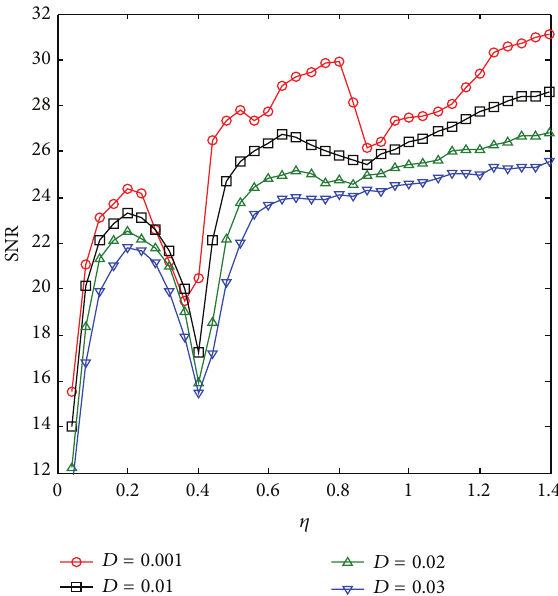
Figure 6: SNR versus the damping coefficient for the different state values of the asymmetric dichotomous noise.